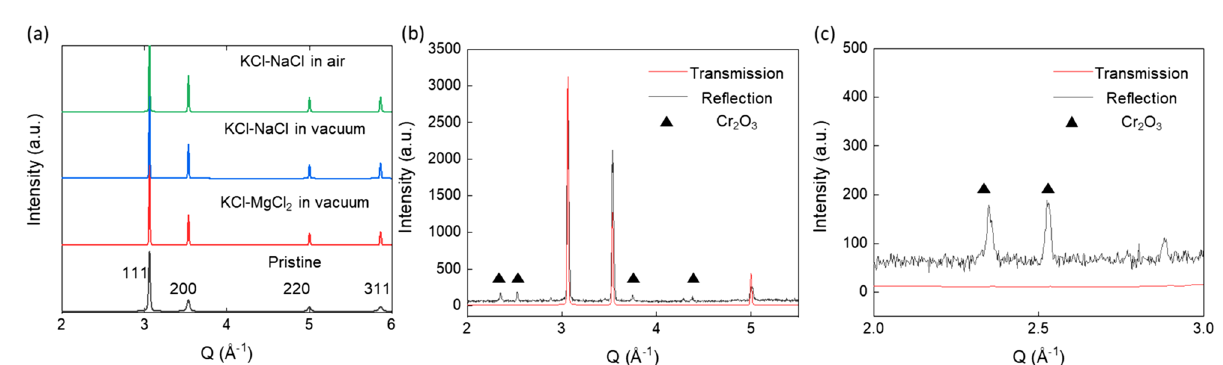
Figure 6. ( a ) XRD patterns of Ni–20Cr foils before and after corrosion in different molten salt conditions for 1 h at 700 °C. The peaks correspond to Ni–20Cr. ( b ) Comparison of XRD pattern of Ni–20Cr foils after corrosion in KCl–NaCl in air, with transmission versus reflection geometries. The main peaks correspond to Ni–20Cr, with Cr 2 O 3 peaks labeled with triangles. A zoom-in view of ( b ) is shown in ( c ) to focus on the Cr 2 O 3 peaks. The x-axis was converted to the Q-space for comparing the signals measured with different incident X-ray energies in the laboratory and synchrotron